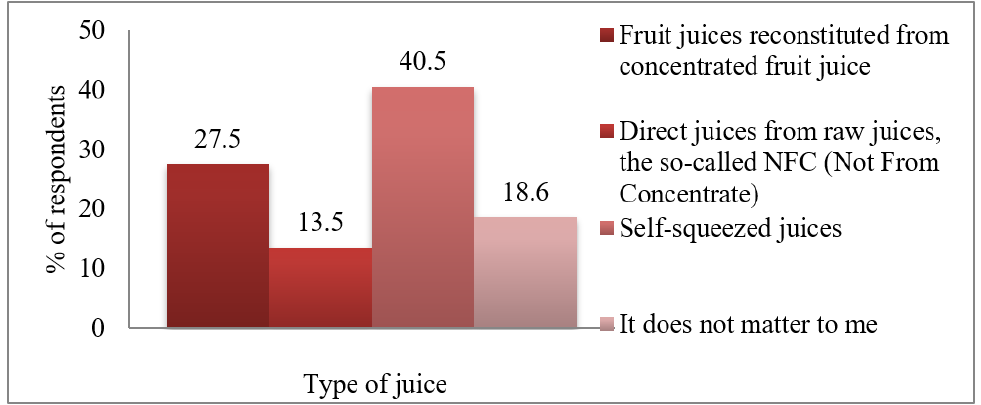
Figure 5. Preferences for choosing the type of citrus juices due to the form of production.